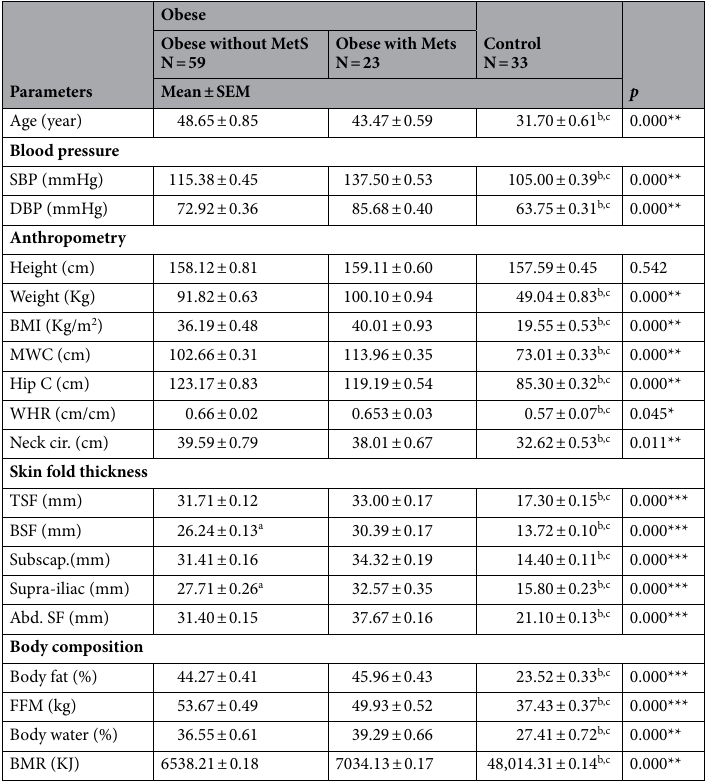
Table 1. Characteristic anthropometric parameters and blood pressure of the studied women ANOVA. BMI, Body Mass Index; BMR, Basal Metabolic Rate; MWC, Minimal Waist Circumference; TSF, Triceps slin fold; BSF; Biceps skin fold; SBP, Systolic Blood Pressure; DBP, Diastolic Blood Pressure. *Significant at p ≤ 0.05, **highly Significant at p ≤ 0.01. *** very highly Significant at p ≤ 0.001. a Obese without MetS V Obese with Mets, b Obese without MetS V Control, c Obese with Mets V Control.